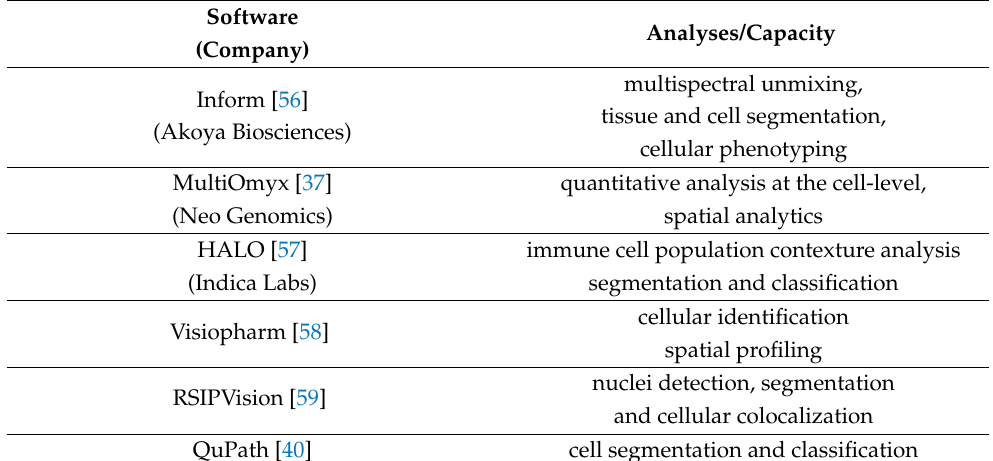
Table 2. Available software for multiplex analyses, compatible with the various platforms and assays.